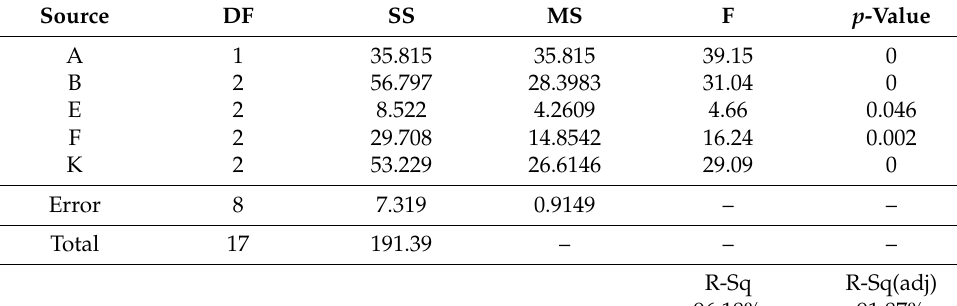
Figure 14. The response graph for the average luminance of the L 18 (2 1 × 3 7 ) experiment. Table 13. ANOVA on values of the average luminance of the L 18 (2 1 × 3 7 )